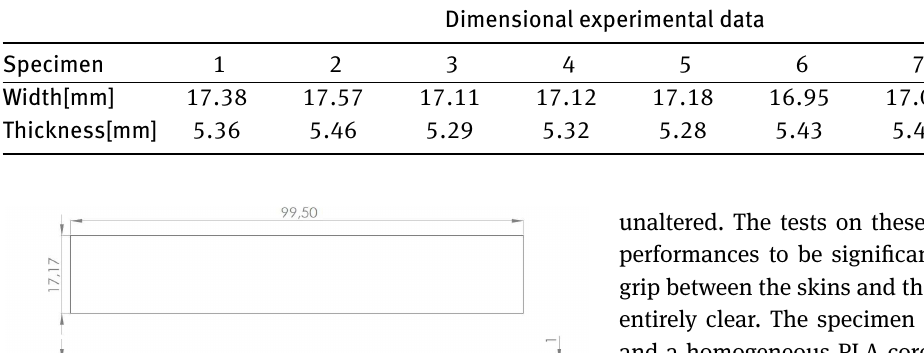
Table 2: Dimensional experimental data for the eight specimens.